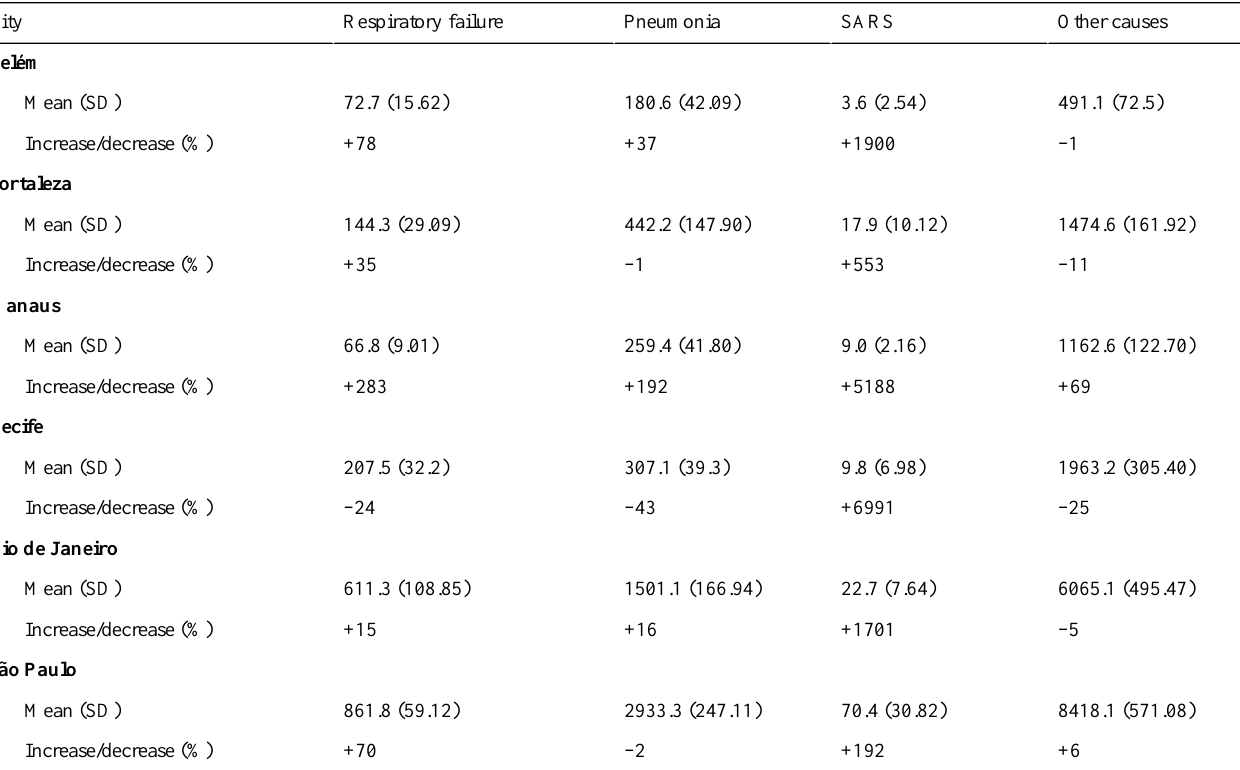
Table 3. Mean (SD) for the historical series and percent increase/decrease of deaths caused by respiratory failure, pneumonia, severe acute respiratory syndrome (SARS), and other